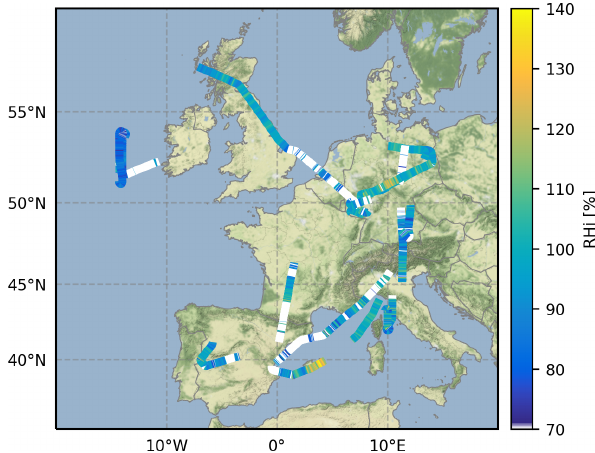
Figure 1. Lidar legs of the research flights conducted during the ML-CIRRUS campaign. The color scale represents the mean RHi of the vertical column from cloud base to cloud top. The white color represents columns for which the mean RHi is 70% or less or re- gions where no ice clouds were measured along the flight